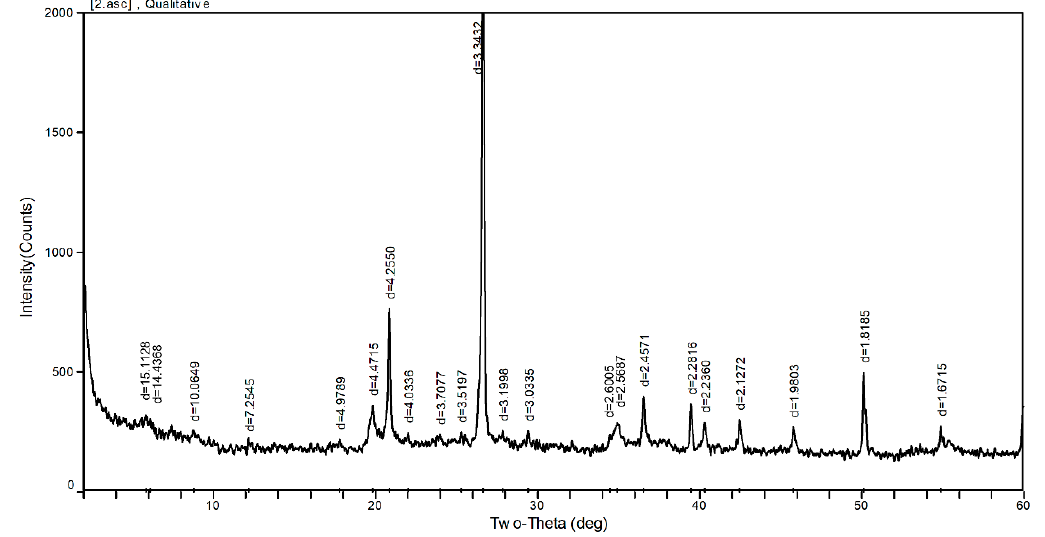
Figure 1. XRD pattern of the expansive soil. Table 2. The results of XRD tests on the expansive soil.